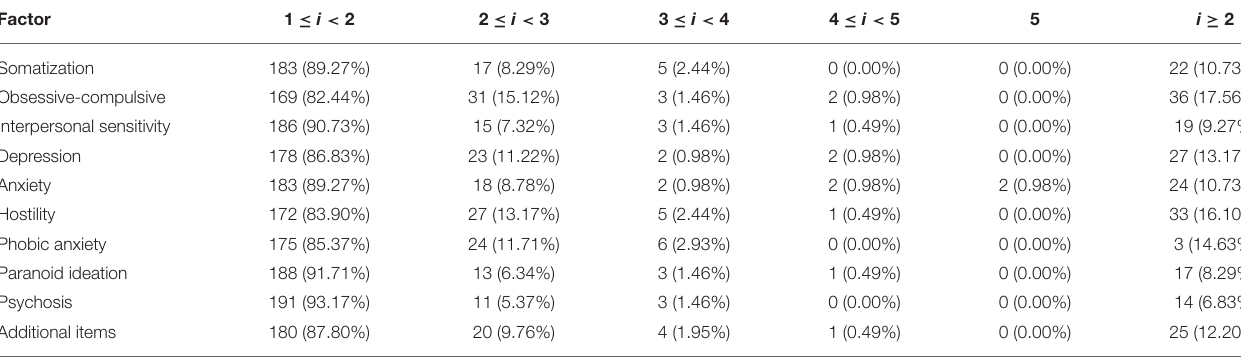
TABLE 2 | The distribution of SCL-90 score among all pregnant women in this study [ n (%)].